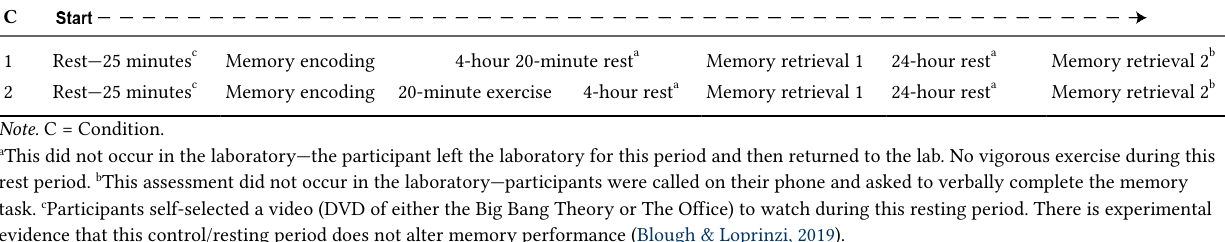
Memory Results (Words Recalled) for Experiment 2